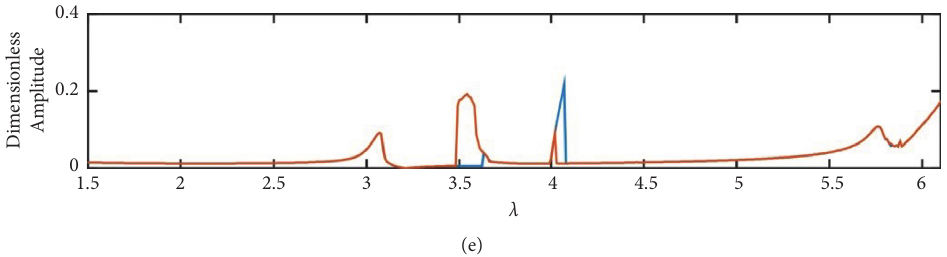
Figure 13: The amplitude-frequency curves of the left end journal in horizontal direction when (a) N N � 12, and (e) N � 13 (blue line means run-up process and brown line means run-down b b